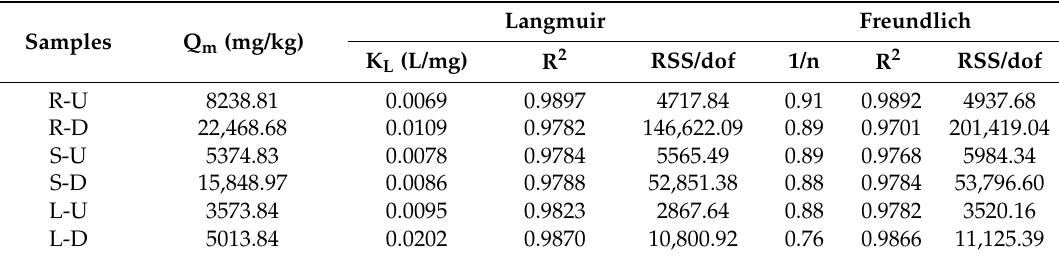
Table 2. The parameters of isotherm models.